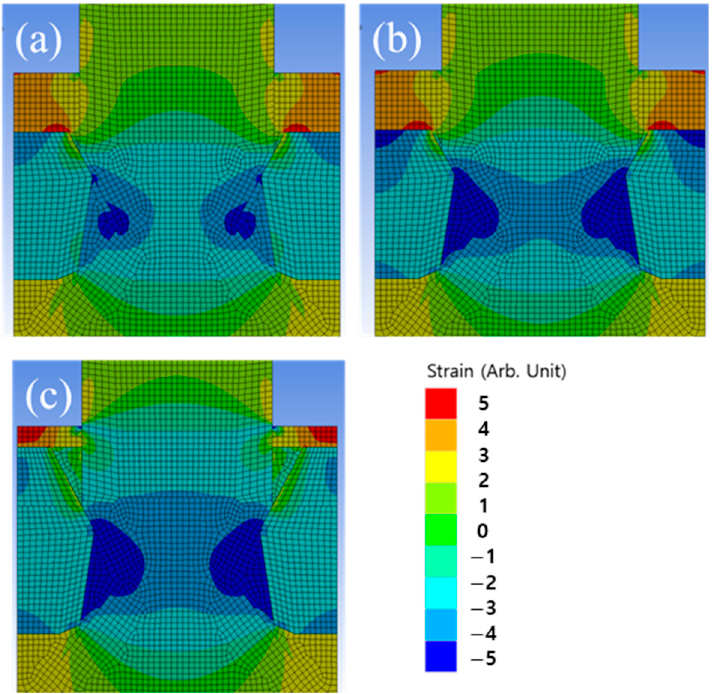
Figure 3. Simulated strain maps for ( a ) C Ge = 50 at.%, ( b ) 55 at.% and ( c ) 60 at.% in SiGe of L2. To verify the change in actual strain of the Si channel, the strain was measured at five points through NBD analysis, as marked by red circles in the inset of Figure 4a. The Si channel with the e-SiGe S/D region, including L2 at C Ge = 50 at.%, displayed a strain of approximately − 0.44% at the center (point 3). This value remained almost constant regardless of the measurement position. When the C Ge was increased to 55 at.%, the strain shifted to approximately − 1.02%. This indicates that the compressive stress induced by the extended S/D was effectively applied to the Si channel, and the stress increased with an increased C Ge in L2. The strain in the Si channel at L2 for C Ge = 55 at.% showed a parabolic distribution with the highest value at position 3. This value can be attributed to the symmetric placement of the S/D [27]. However, when the C Ge in L2 was increased to 60 at.%, the strain became less negative, i.e., the applied stress decreased. Thus, the number of misfit dislocations was counted to verify the change in stress relaxation with increasing C Ge in L2, as shown in Figure 4b. The number of misfit dislocations generated for 100 sigma-shaped cavities was evaluated and statistically organized. L2 with C Ge = 50 at.%, 55 at.%, and 60 at.% showed 2.10, 6.15, and 21.05 misfit dislocations with standard deviations of 1.25, 1.90, and 5.27, respectively. This indicates that an increase in C Ge is accompanied by local stress relaxation. In addition, the misfit dislocations were not generated linearly with increasing C Ge . The steep increase in the number of misfit dislocations between C Ge = 55 at.% and 60 at.% indicates a critical C Ge of approximately 55 at.%–60 at.% for relaxing the stress induced between SiGe and Si. The abovementioned results reveal that the strain induced in the Si channel can be maximized by optimizing the C Ge with respect to stress generation and relaxation.